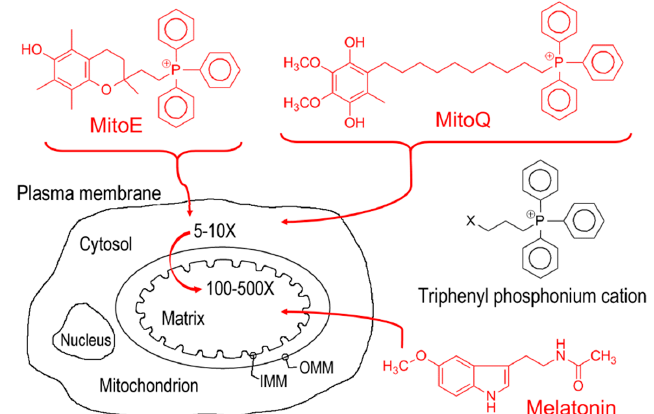
Figure 1. Coupling native vitamin E and coenzyme Q10 to the triphenyl phosphonium cation (at position X) creates molecules referred to as Mito E and Mito Q. These synthetically produced antioxidants are more lipid-soluble than their native precursors and, as a result, they concentrate in the mitochondria, the site of maximal reactive oxygen species generation, up to 500-fold. When these modified antioxidants were compared with melatonin at equimolar concentrations, in terms of their anti-inflammatory and antioxidant actions in mice treated with the bacterial toxins lipopolysaccharide and peptidoglycan G, melatonin was equally effective on most parameters measured and in some cases, melatonin was superior. This attests to the outstanding efficacy of melatonin as to its function as an anti-inflammatory agent and use as an